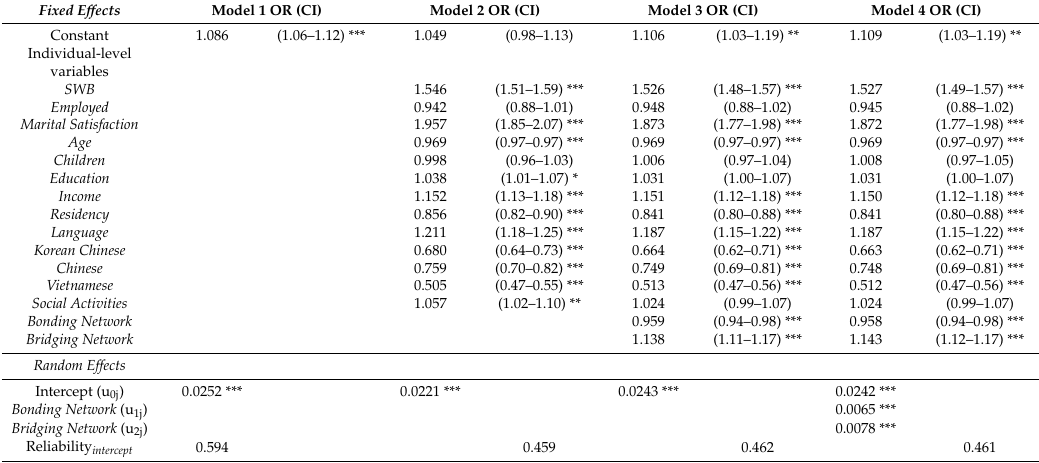
Table 3. Multilevel models of the associations between SRH and social capital measures (Individual-level covariates only).